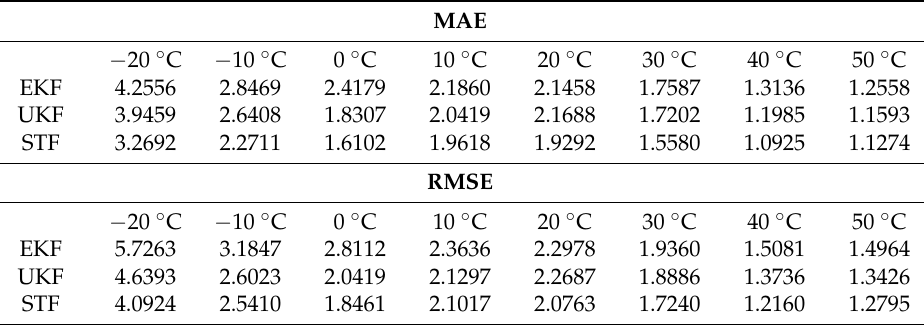
Figure 13. The MAE and RMSE of EKF, UKF, and STF at different temperatures. Table 4. The statistical data of MAE and RMSE for EKF, UKF, and STF.